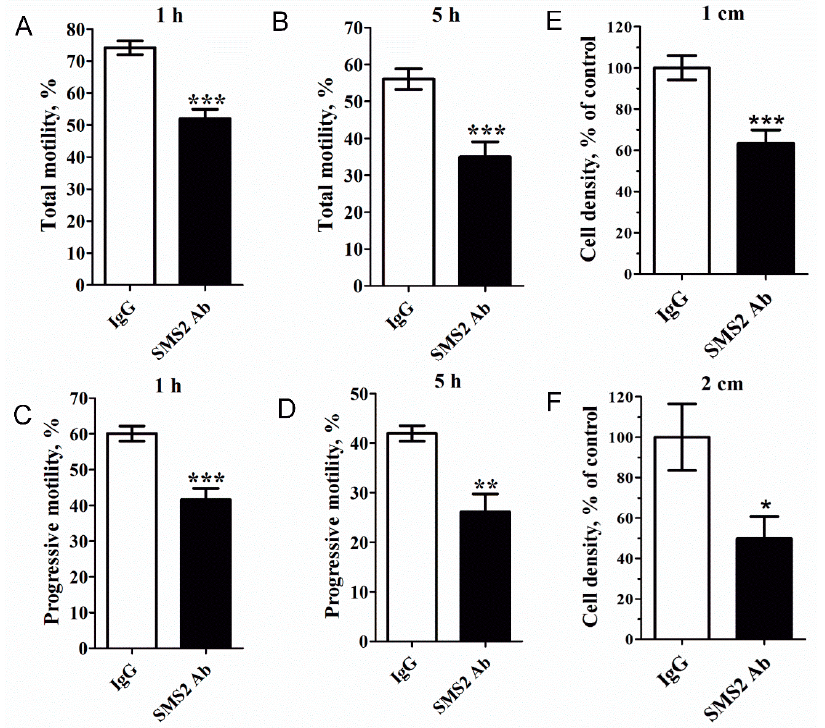
Figure 4. The effect of SMS2 inhibition on sperm motility and penetration ability into methylcellulose. ( A–D ) Inhibition of the SMS2 activity affects sperm motility; (E , F) the effect of SMS2 inhibition on penetration ability into methylcellulose. Values shown are the mean ± SD ( n = 9). * p < 0.05, ** p < 0.005, and *** p < 0.001 vs. IgG group.